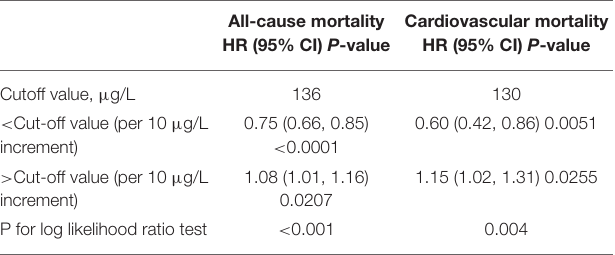
TABLE 4 | The results of two-piecewise linear regression model between selenium levels and all-cause or cardiovascular